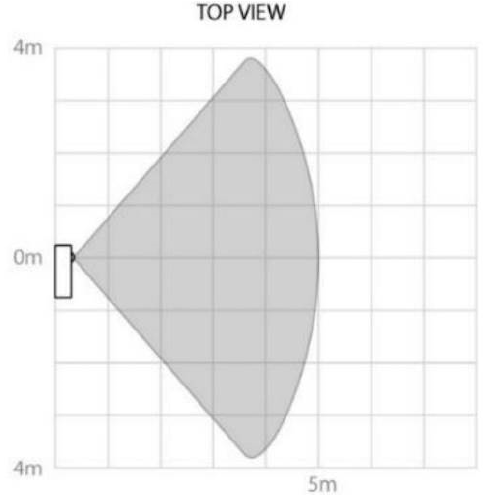
Figure A2. Range and angle of view [69].